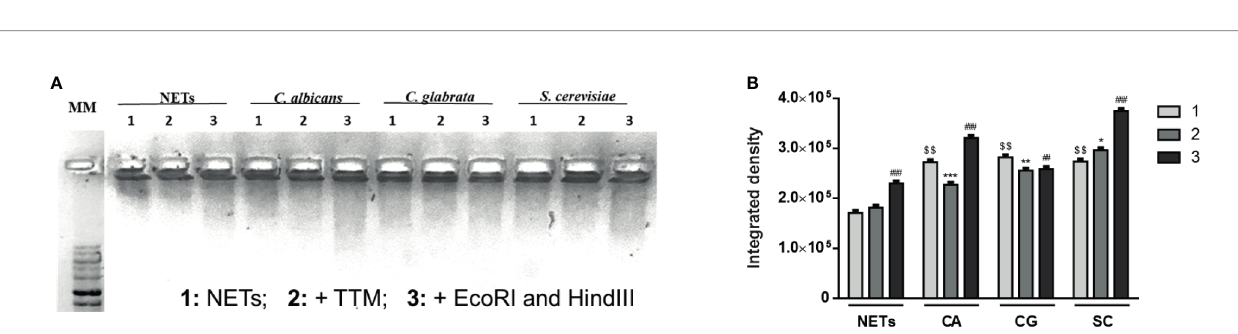
FIGURE 6 | NETs digestion in the presence of yeasts. NET-enriched supernatants were used under different conditions: NETs, NETs with C. albicans (CA), NETs with C. glabrata (CG), and NETs with S. cerevisiae (SC) (1); each condition was also co-incubated with 100 m M TTM (2) for 3 h and restriction enzymes (EcoRI and HindIII) were added at each condition for an additional 30 min period (3). Samples were run on a 1% GreenSafe agarose gel to evaluate yeast ’ s ability to digest nucleic acids and NETs ( A ; representative image of a set of different experiments) and nucleic acids smears integrated density (mean gray values x area) were quanti fi ed (B) . $$p<0.01, yeasts-NETs vs. neutrophil-NETs; *p<0.05, SC TTM treatment (2) vs. SC NETs (1); **p<0.01, CG TTM treatment (2) vs. CG NETs (1); ***p<0.001, CA TTM treatment (2) vs. CA NETs (1); ## p<0.01, CG restriction enzymes treatment (3) vs. CG NETs (1); ### p<0.001, NETs, CA, and SC restriction enzymes treatment (3) vs. NETs, CA, and SC NETs (1), respectively.